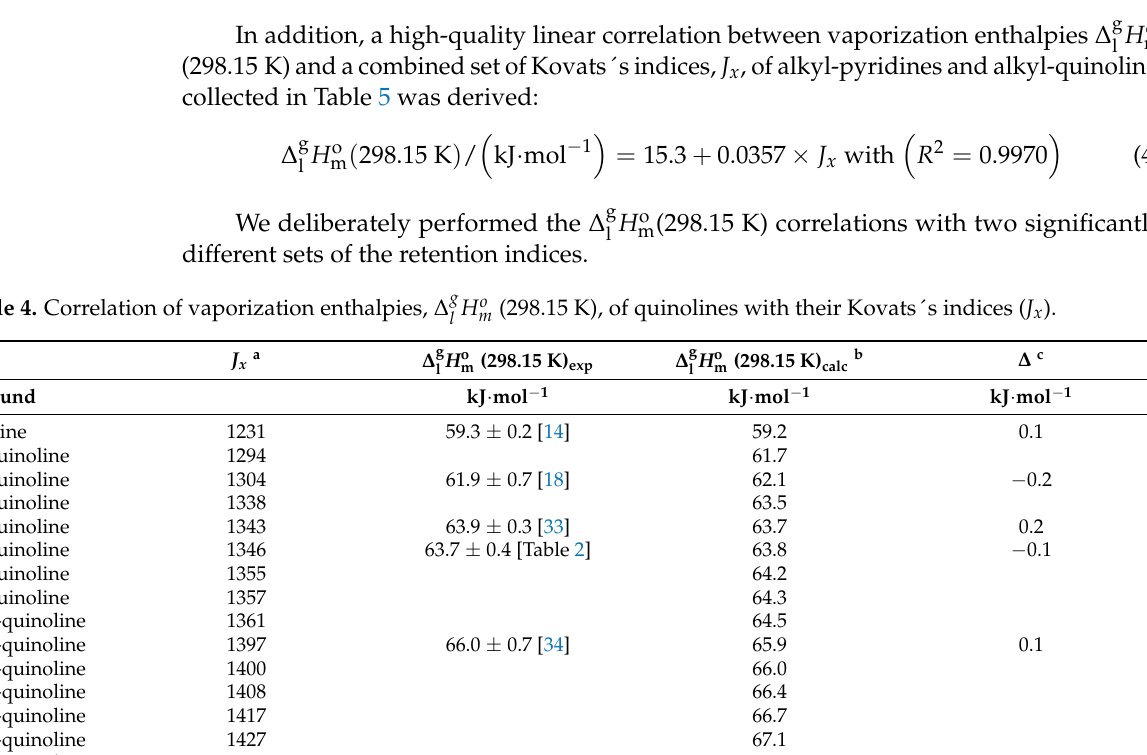
Table 4. Correlation of vaporization enthalpies, ∆ g